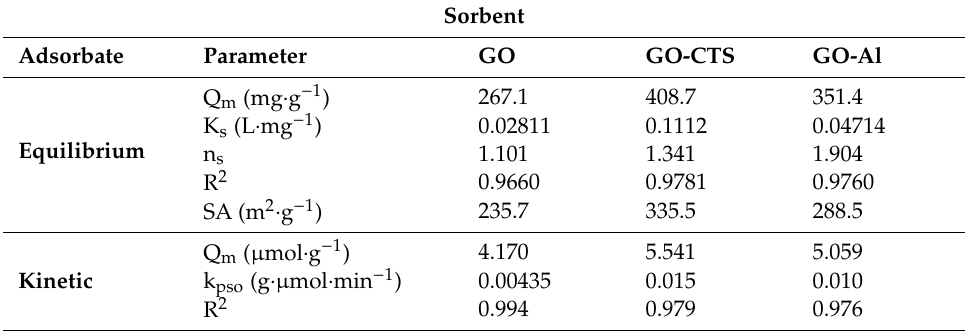
Table 1. Sips and PSO adsorption isotherm parameters for GO-based composites with MB at pH 6 and 295